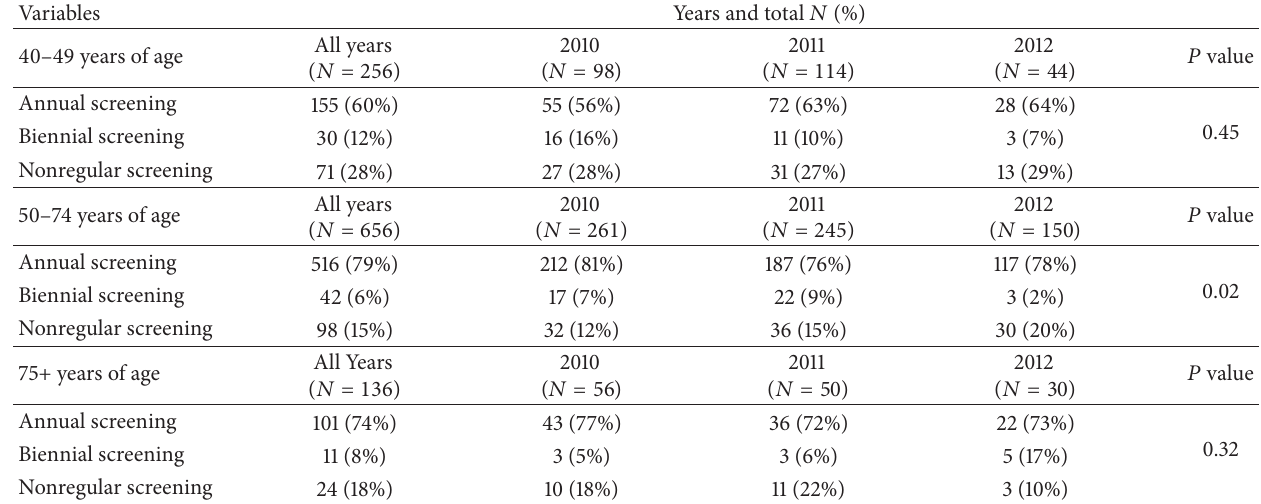
Table 2: Screening frequency by age groups over time.